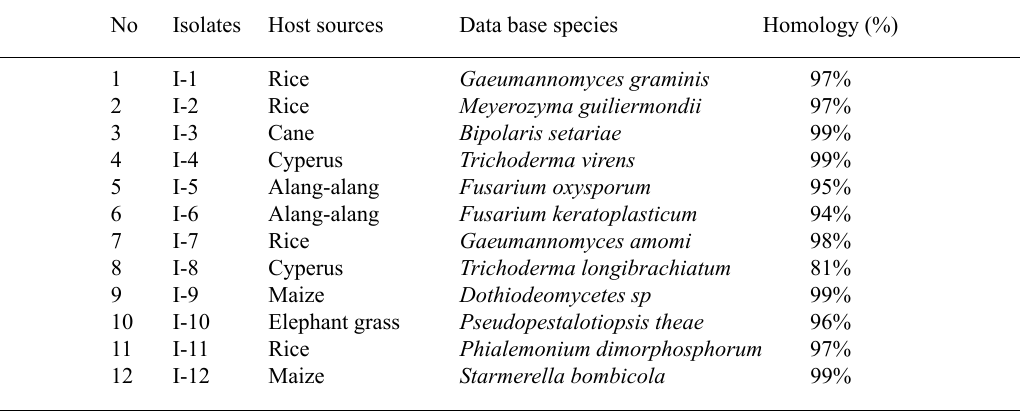
List of isolates species identity homology with NCBI databse